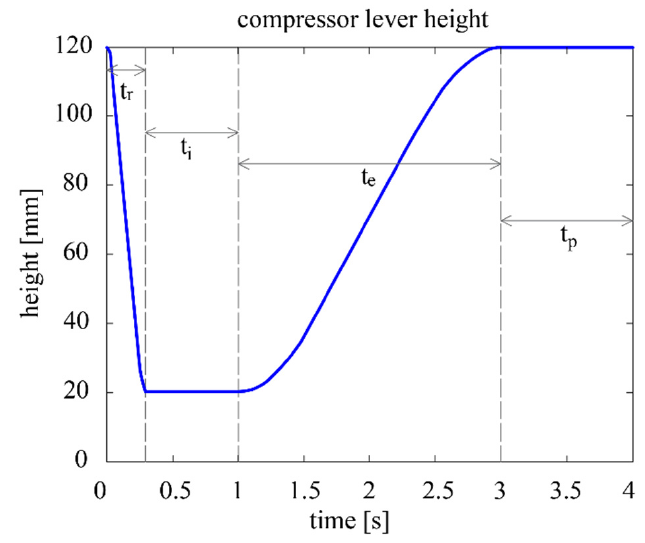
Figure 3. Compressor lever height vs. time at 15 cycles per minute.